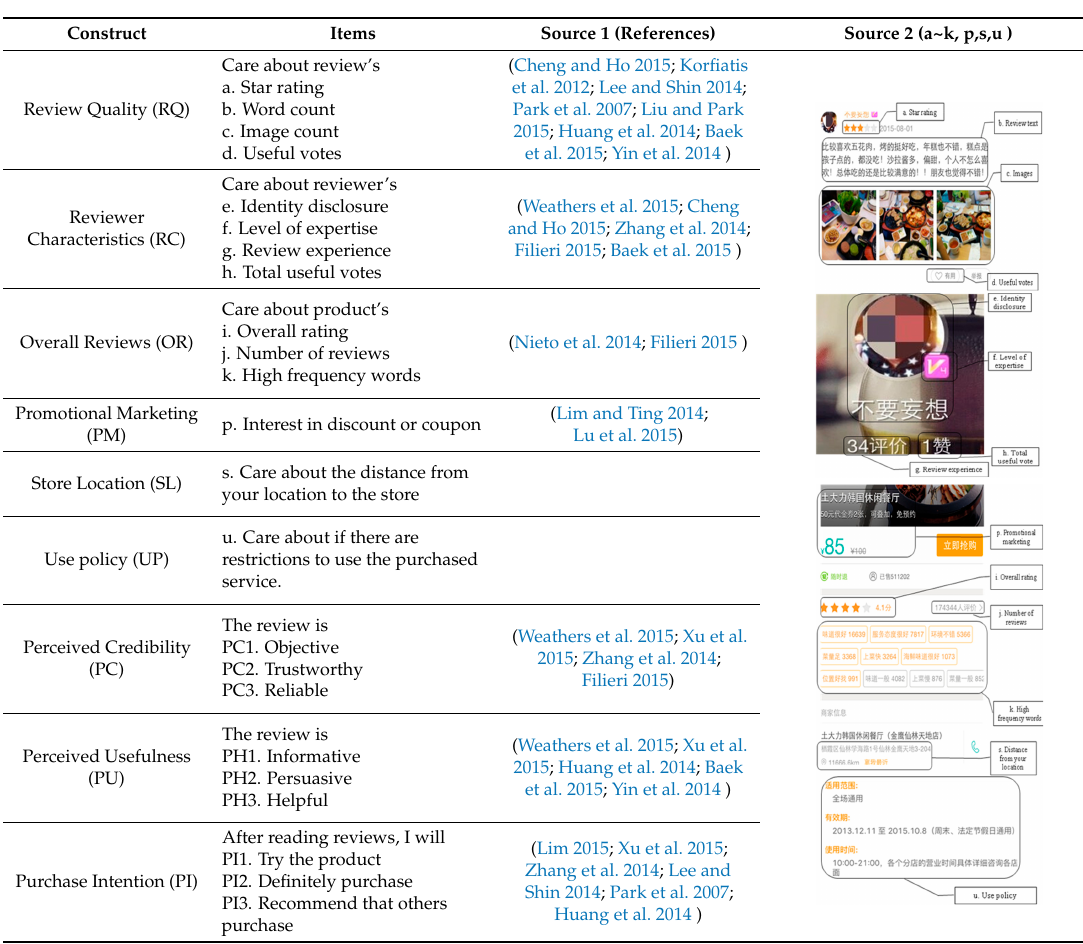
Table A1. Items used in the study.